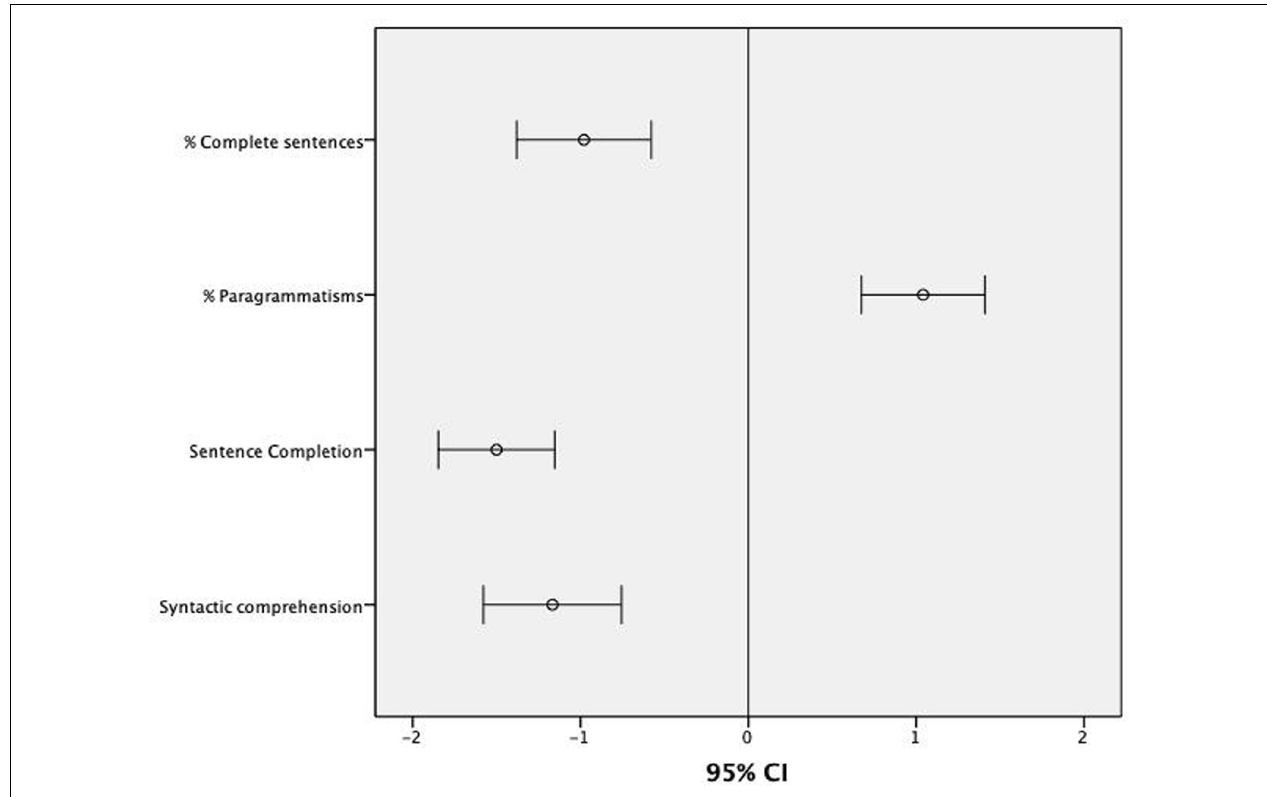
FIGURE 2 | Mean z-scores and 95% CIs for the scores assessing grammatical skills in children with ASD in relation to normative data.